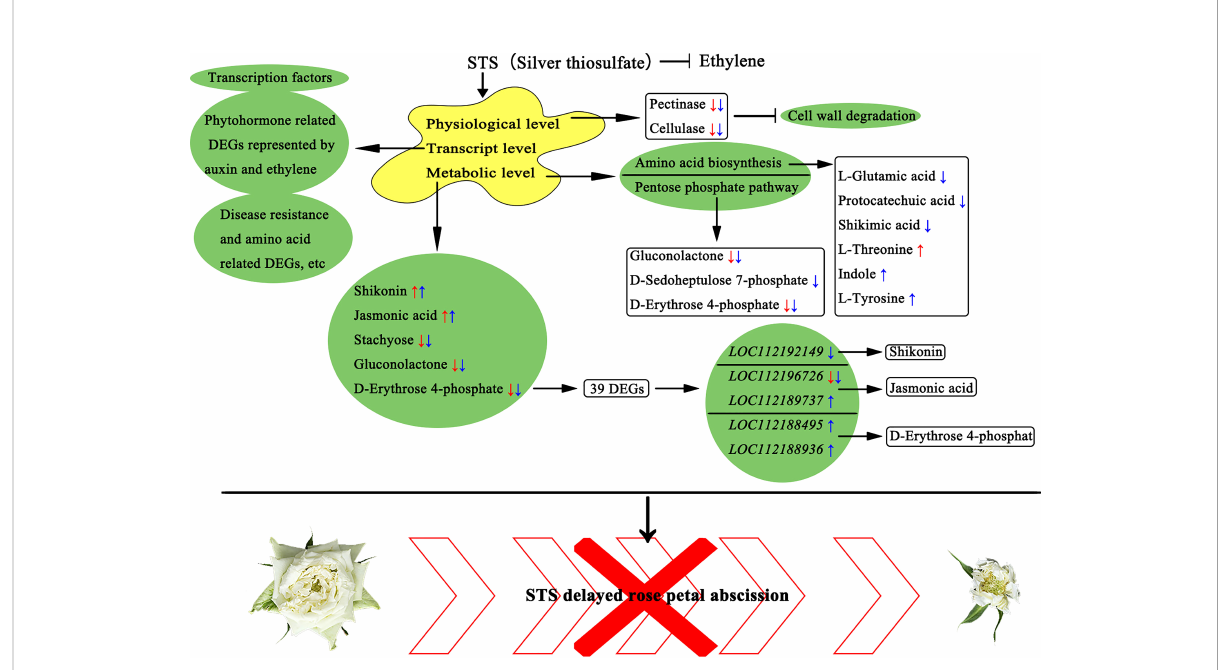
FIGURE 9 A proposed model of STS negatively in fl uences petal abscission of rose. The red arrows indicated the up- or down- regulated in STS24h vs. MOCK24h; the blue arrows indicate the up- or down- regulated in STS24h vs. Eth24h. Scale bar, 5